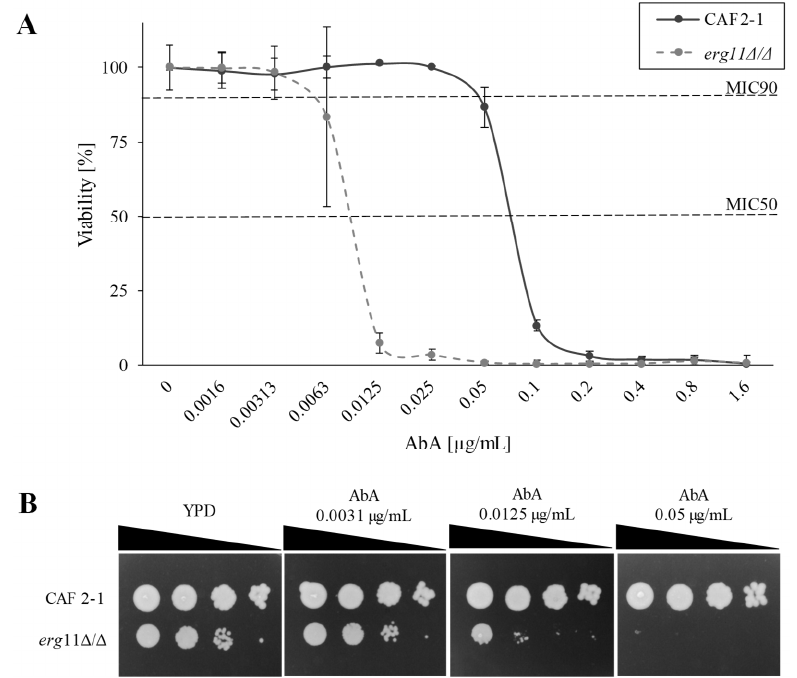
Figure 3. The viability of C. albicans CAF2-1 and erg11 ∆ / ∆ strains in the presence of AbA. ( A ) MIC values for CAF2-1 (WT) and KS028 ( erg11 ∆ / ∆ ) strains in the presence of AbA (0–1.6 μ g/mL) after 24 h culture in YPD medium. ( B ) Growth phenotypes of C. albicans CAF2-1 and erg11 ∆ / ∆ strains after 48 h of incubation at 28 ◦ C in YPD agar plates, supplemented with